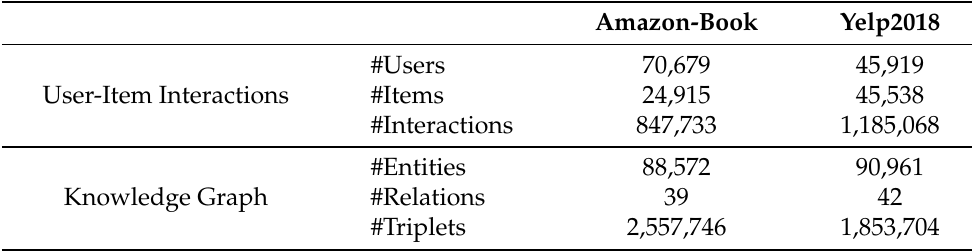
Table 1. Statistics of the datasets in